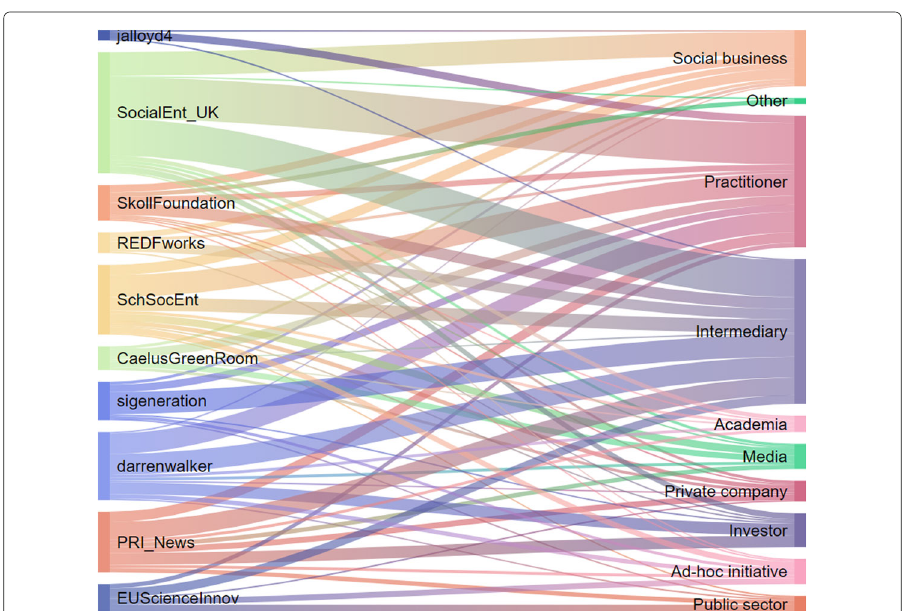
Fig. 7 Mapping of the retweet communities (left-hand side) to influential user categories (right-hand side). Most of the retweet communities (left-hand side) have users from most of the categories (right-hand side), except the community lead by @jalloyd4, whose users are mainly practitioners with a small presence of social businesses and intermediaries